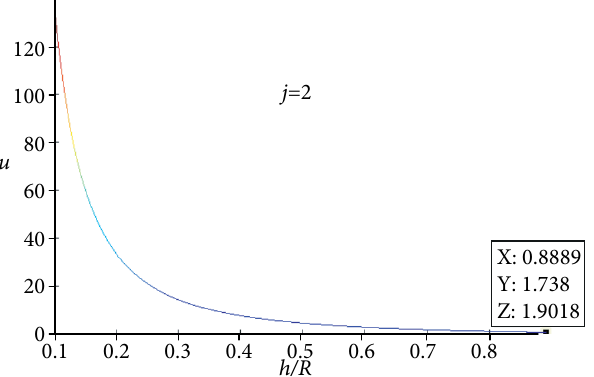
Figure 16. The relationship between the parameter u and h/R in the 2nd